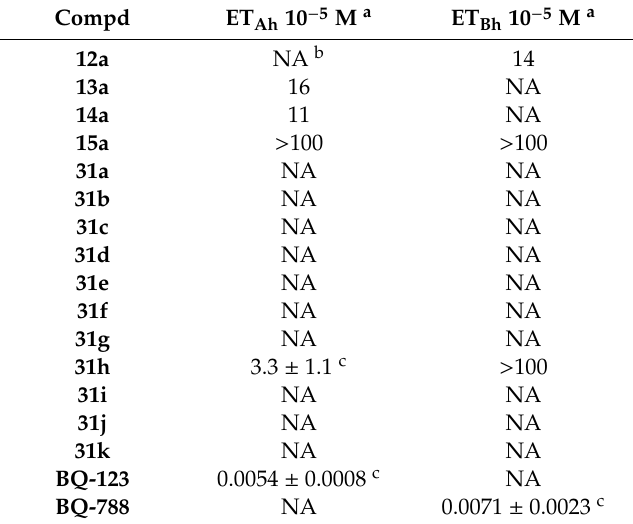
Table 2. Binding properties of compounds 12a – 15a and 31a – k